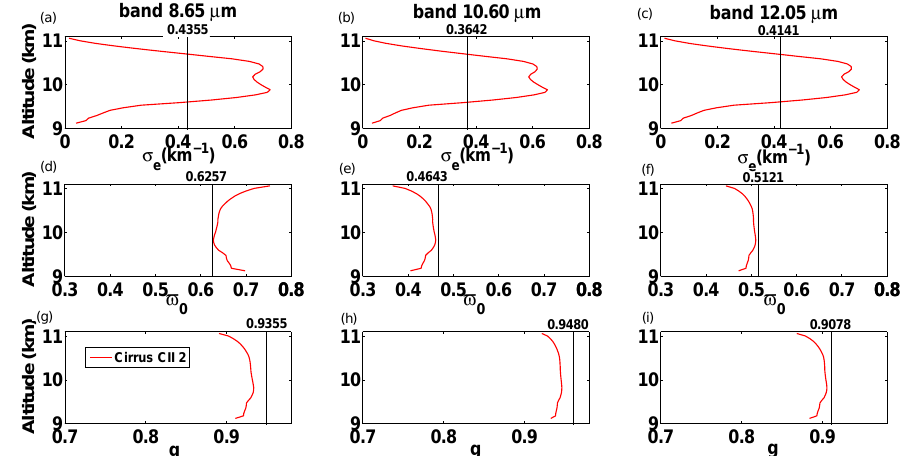
Figure 12. (a) , (b) and (c) : vertical variation of the mean extinction coefficient σ e ; (d) , (e) and (f) : vertical variation of the mean single- scattering albedo (cid:36) 0 ; (g) , (h) and (i) : vertical variation of the asymmetry factor g for the three IIR channels at 8.65, 10.60µm and 12.05 for cirrus CII-2. Vertical black lines correspond to the mean value of the optical coefficient obtained after vertical averaging of the IWC.